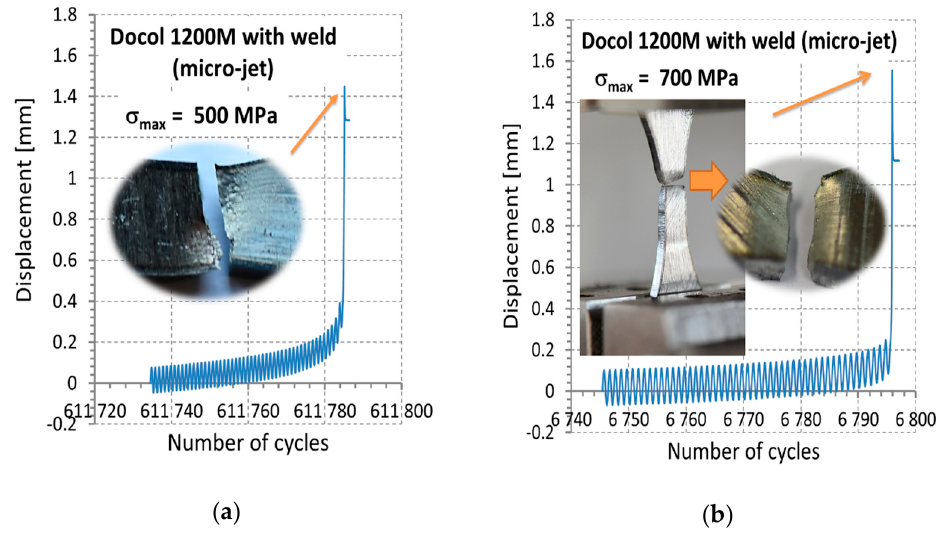
Figure 11. The last stage of fatigue tests before fracture of the Docol 1200 M steel’s micro-jet cooling weld for the following maximum values of stress: ( a ) 500 MPa and ( b ) 700 MPa.